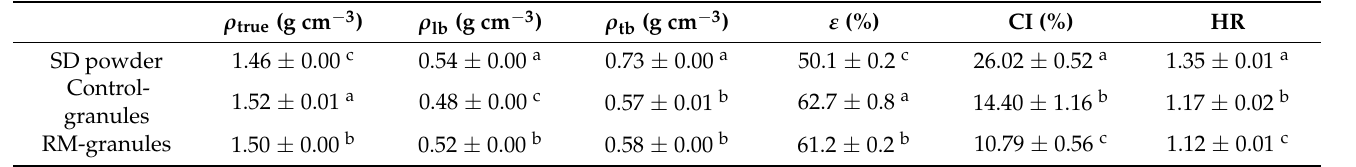
Table 2. True density ( ρ true ), loose bulk density ( ρ lb ), tapped bulk density ( ρ tb ), Carr